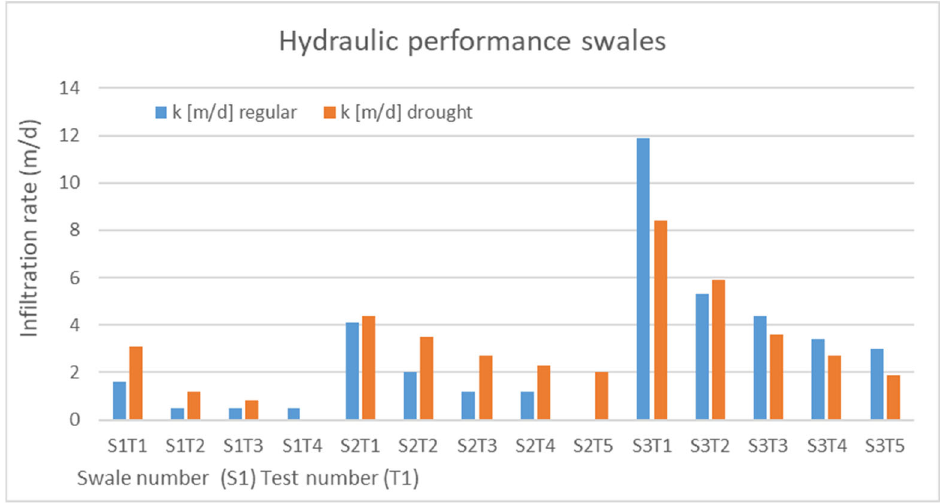
Figure 11. Infiltration rate in m/d (results of linear regression analysis).